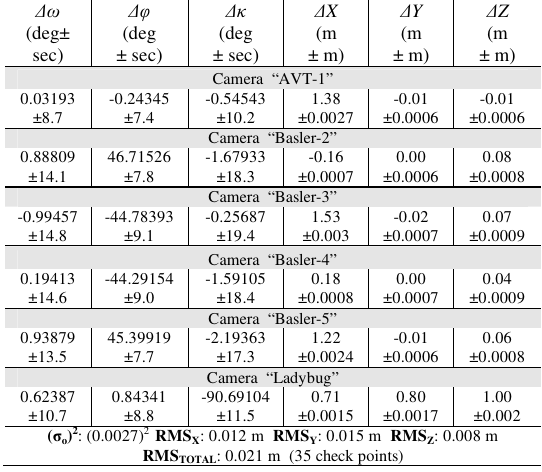
Table 2. Estimated lever-arm offsets and boresight angles w.r.t. camera “AVT-0” using the indirect geo-referencing with ROC procedure.